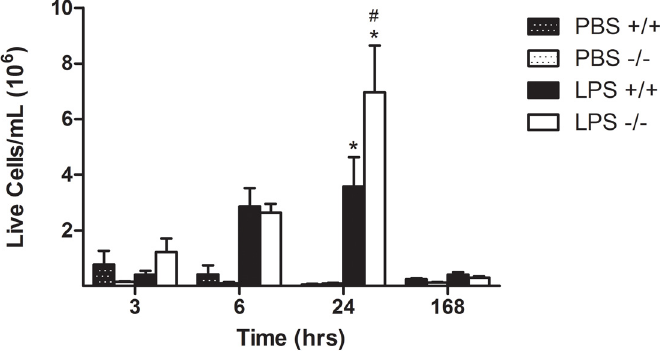
Fig 2. Time course of LPS-induced airway inflammation. Leukocytes were collected from the airway compartment by BAL at various timepoints up to 7 days (168h) after intratracheal instillation of 1 μ g LPS. The number of live cells was determined by trypan blue exclusion. Live cell counts are displayed for PBS control and LPS-exposed Duoxa -/- (-/-) and Duoxa +/+ (+/+) mice as indicated. Data are shown as mean ± SEM for six mice in each group; * = p < 0.05 between LPS-treated and PBS-treated controls, # = p < 0.05 between LPS- treated Duoxa +/+ and Duoxa -/- mice.